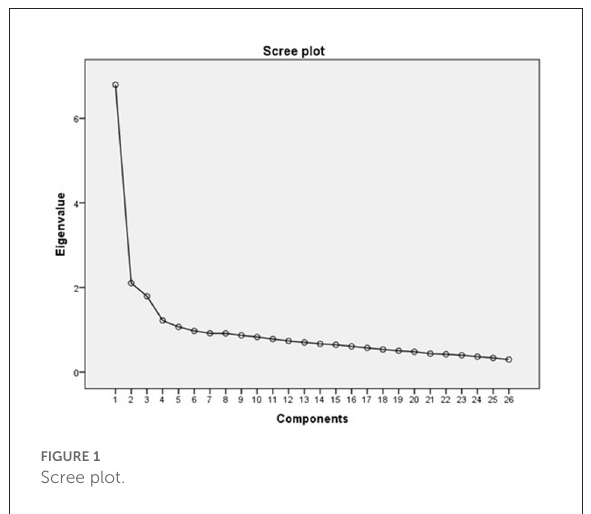
FIGURE1 Scree plot.